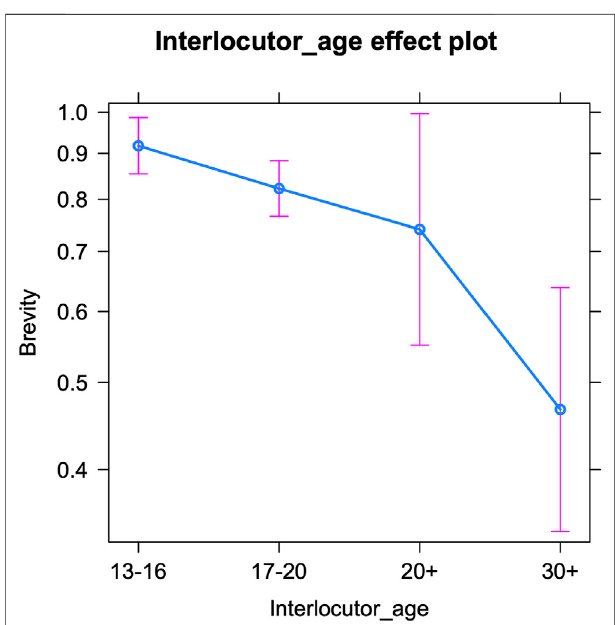
FIGURE 6 | Brevity markers per interlocutor age (predicted counts per 100